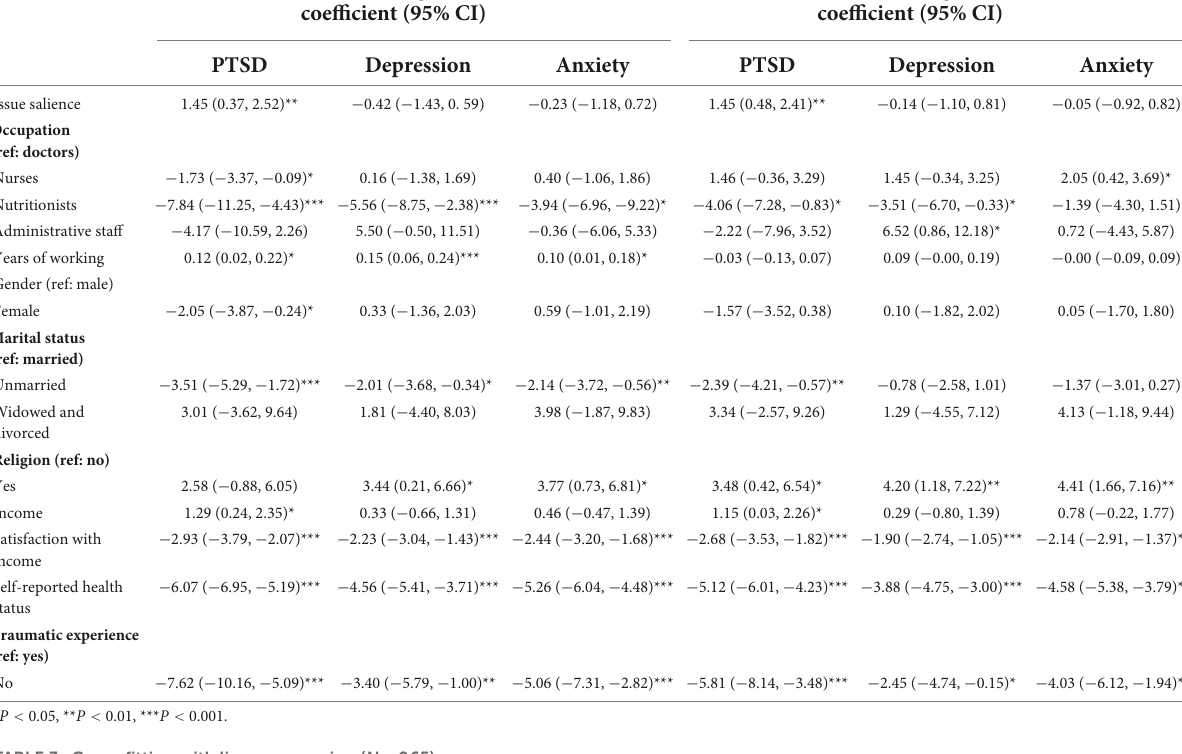
TABLE 2 Regression analysis ( N = 965).